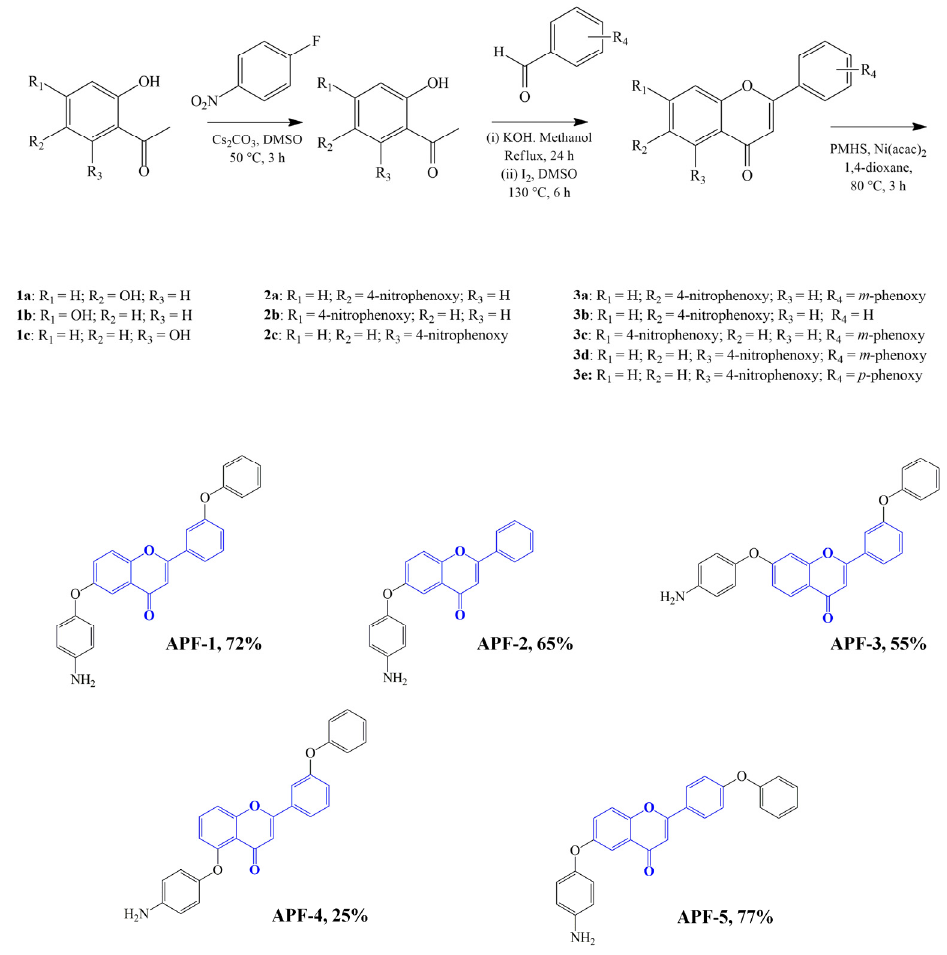
Scheme 1. Synthetic routes used for the synthesis of aminophenoxy flavone compounds and chemical structure of synthetized aminophenoxy flavone derivatives ( APF ). Table 1. Experimental LogP and Lipinski’s Rule violations of the